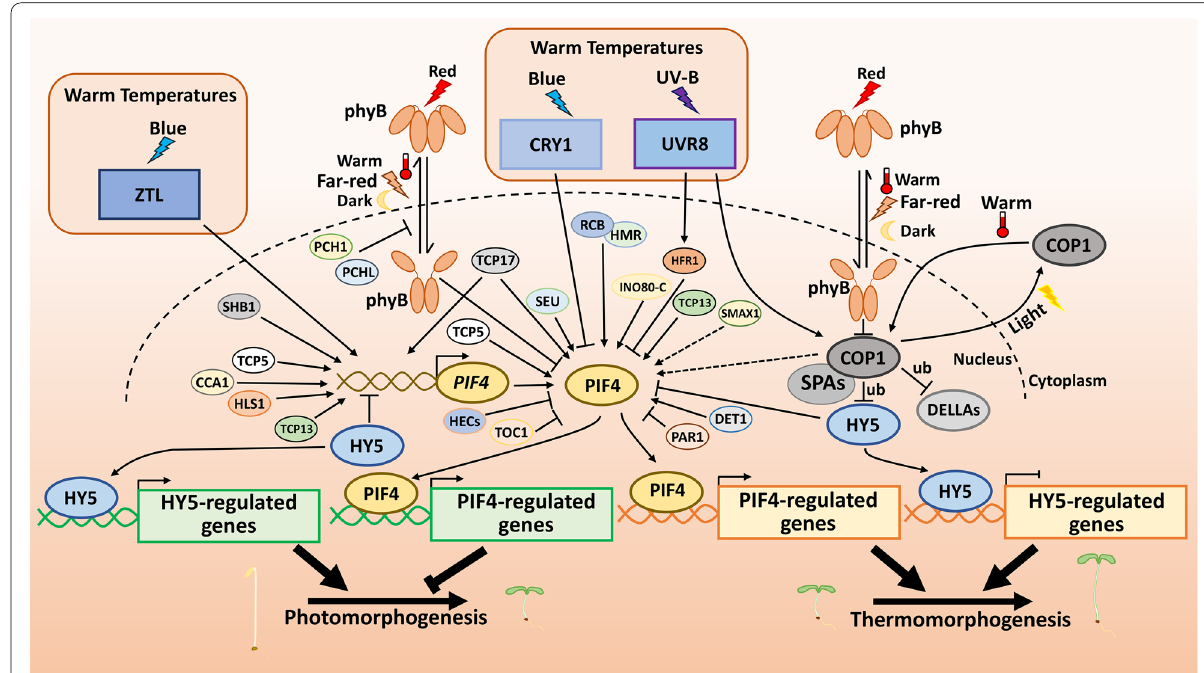
Fig. 2 PIF4 and COP1-HY5 integrate light and warm temperature signaling. Warm temperatures trigger the conversion of phyB from active Pfr to inactive Pr form, thereby allowing the accumulation of PIF4. HLS1 SHB1 TCP5, TCP13 and TCP17 positively regulate the PIF4 expression , while HY5 represses the expression of PIF4 at the transcriptional level. CCA1, COP1-SPAs, DET1, HMR, IN080-C, RCB, SEU, SMAX1, TCP5, TCP13 and TCP17 enhance the PIF4 action, whereas HECs, HFR1, HY5, PAR1 and TOC1 and inhibit the PIF4 activity at the protein level. In blue light at warm temperatures, ZTL positively controls the transcription of PIF4 , and CRY1 inhibits the PIF4 transcriptional activity. UVR8 not only inhibits the PIF4 activity trough HFR1, but also promotes the COP1 activity in response to UV-B and warm temperatures. Light induces the COP1 translocate from the nucleus to the cytoplasm, whereas warm temperatures have opposite effects on COP1 nuclecytoplamic partioning. COP1 destabilizes the HY5 and DELLA proteins through ubiquitinaiton at warm temperatures. ub represents